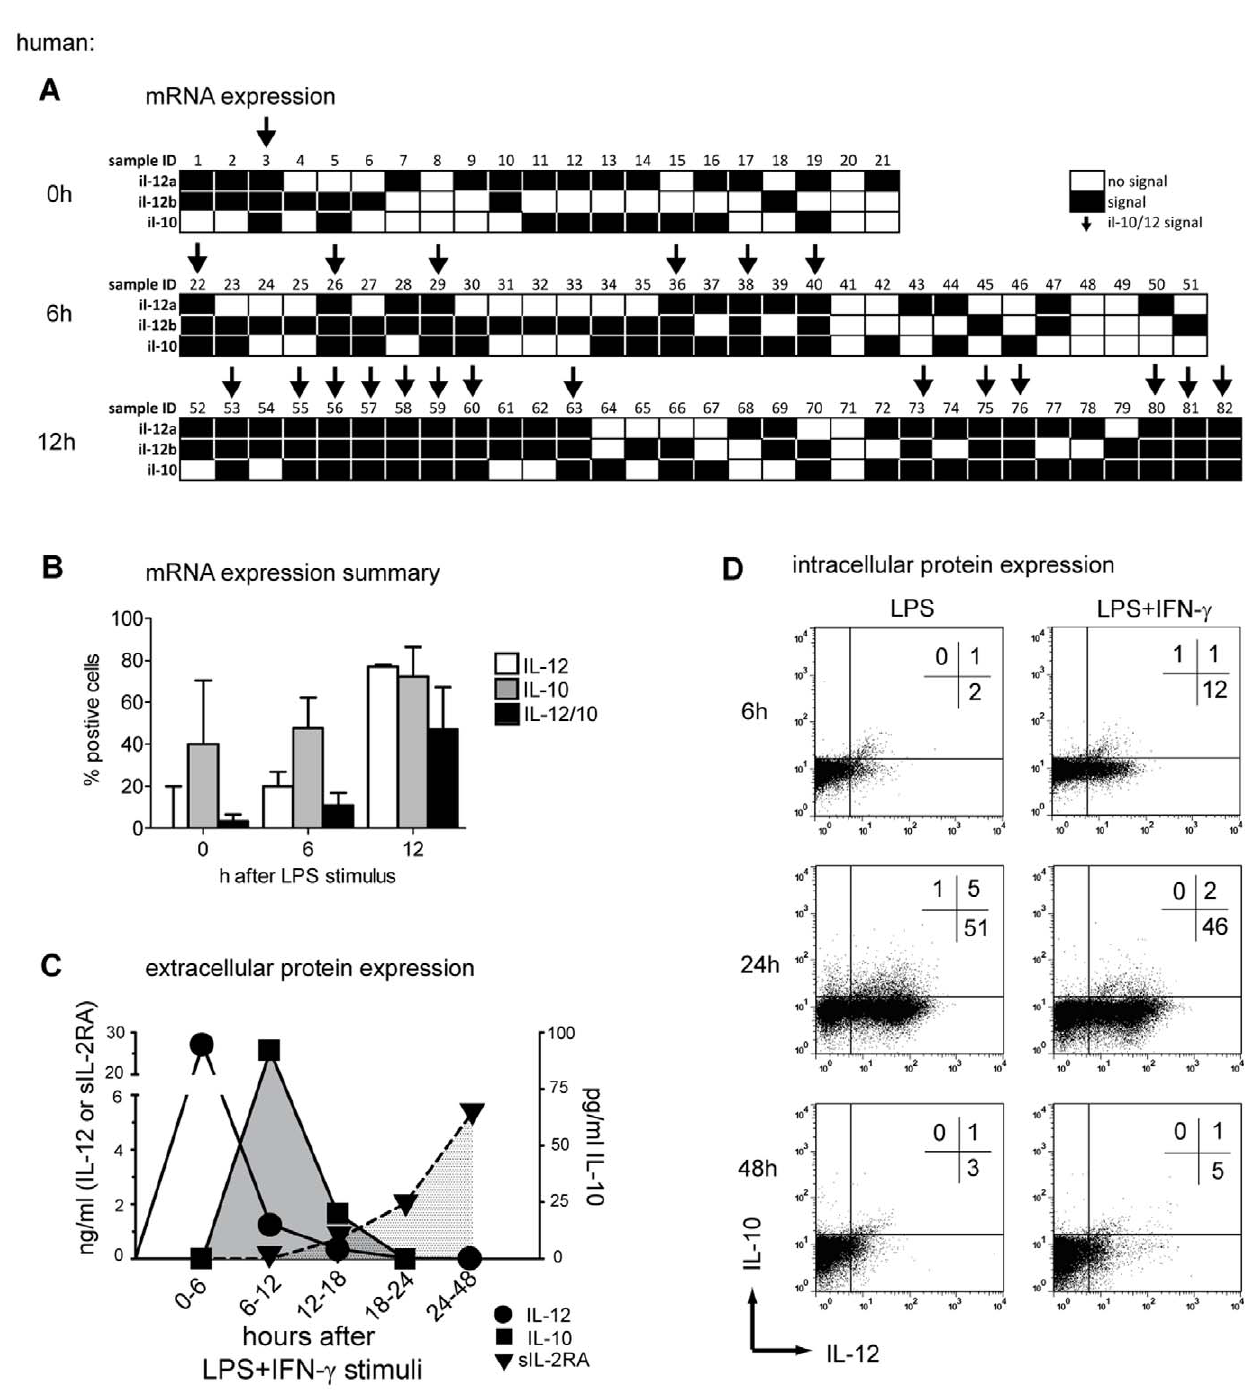
Figure 5. Production of IL-12 and IL-10 on a single-cell level in DCs. (A) Real-Time PCR was used to assess IL-12p35, IL-12p40 and IL-10 mRNA on single cell levels before and after 6 or 12 hours exposure to LPS. All b2m positive sorted single cells were further analyzed for IL-12p35, IL12-p40 and IL-10. Every single cell is depicted (sample ID) for signal (black), no signal (white) and mRNA signal of all three targets (arrow). (B) The summary of 3 independent experiments is depicted as median 6 SEM. Bars represent the percentage of IL-10 (grey bars), IL-12 (white bars, p35/p40 double positive signals) or IL-10/IL-12 double producing cells (black bars). (C) The concentration of freshly secreted IL-12 (circles), IL-10 (squares), and soluble IL-2RA (triangles) from LPS/IFN- c activated human DCs is shown in 6 hours intervals after LPS/IFN- c maturation. At each time point the entire medium was exchanged in order to assess only freshly produced cytokines during the respective time intervals. One representative out of 3 experiments is shown. (D) Intracellular staining of IL-10 and IL-12 protein before and after 6, 24, and 48 hours of exposure to LPS or LPS/IFN- c . Quadrants are adjusted to the fluorescence of antibody-labeled immature DCs. One representative experiment of 2 is shown. DCs from Donor A and F were used in experiment (A) to